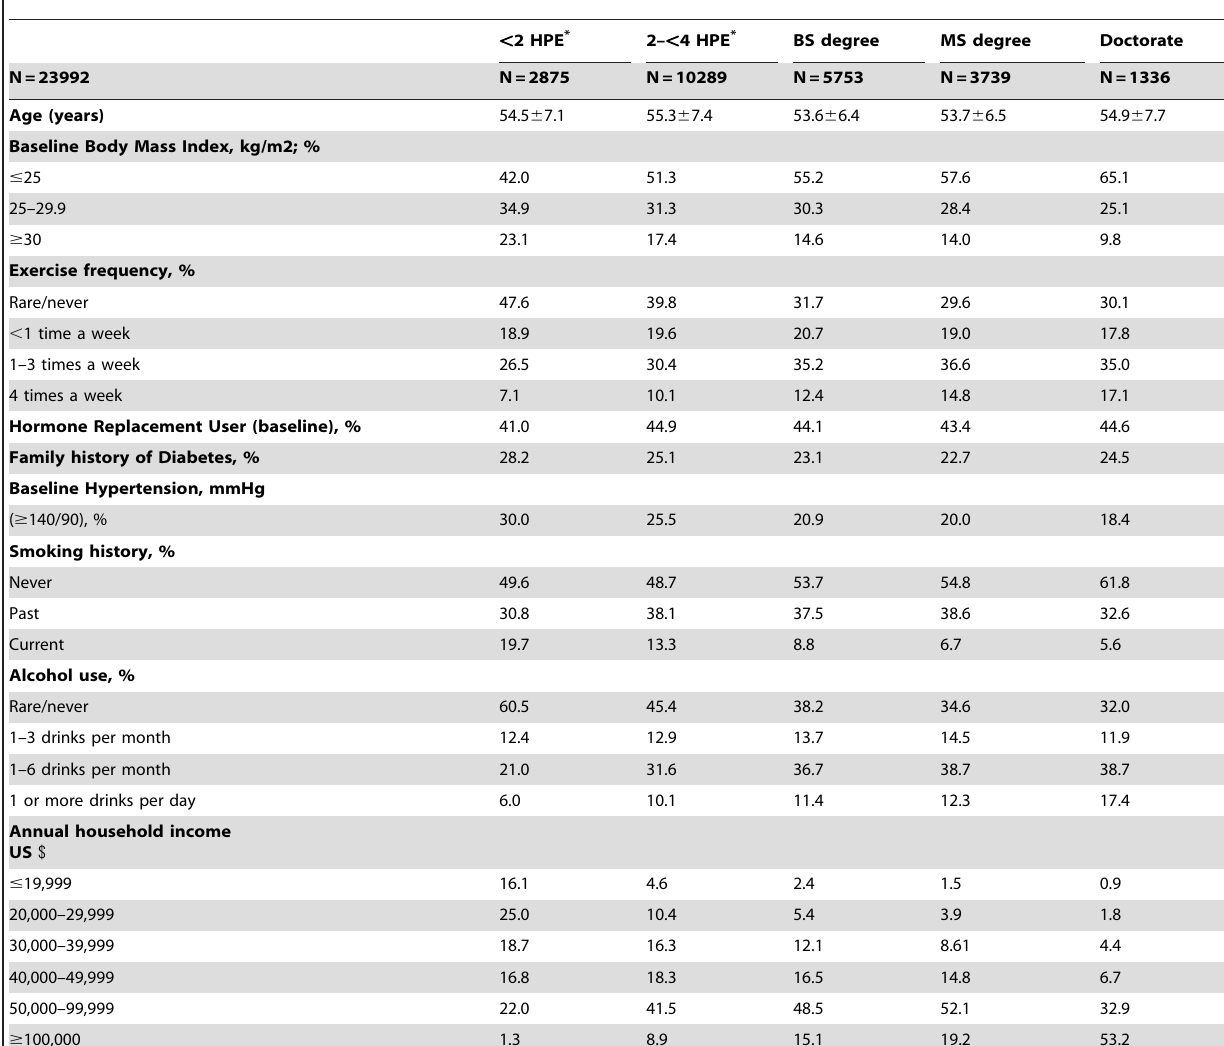
Table 1. Baseline Characteristics by Education